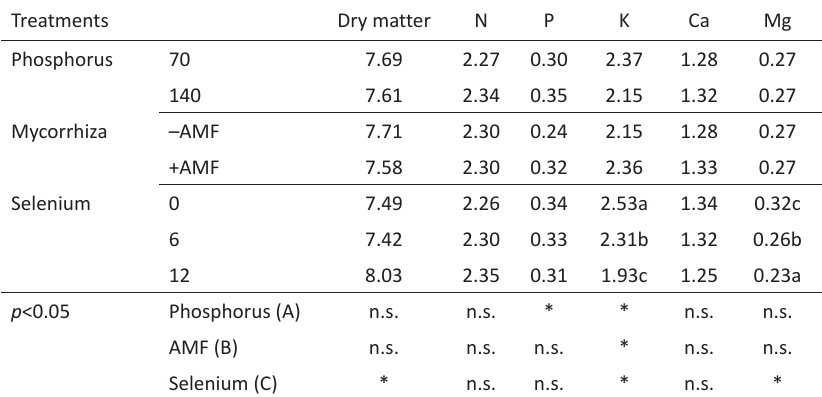
Table 3. Effect of mycorrhiza on dry matter (%) and macronutrient (% d.m.) contents in lettuce grown on medium with different levels of phosphorus and selenium (mg dm -3 ) Treatments Dry matter